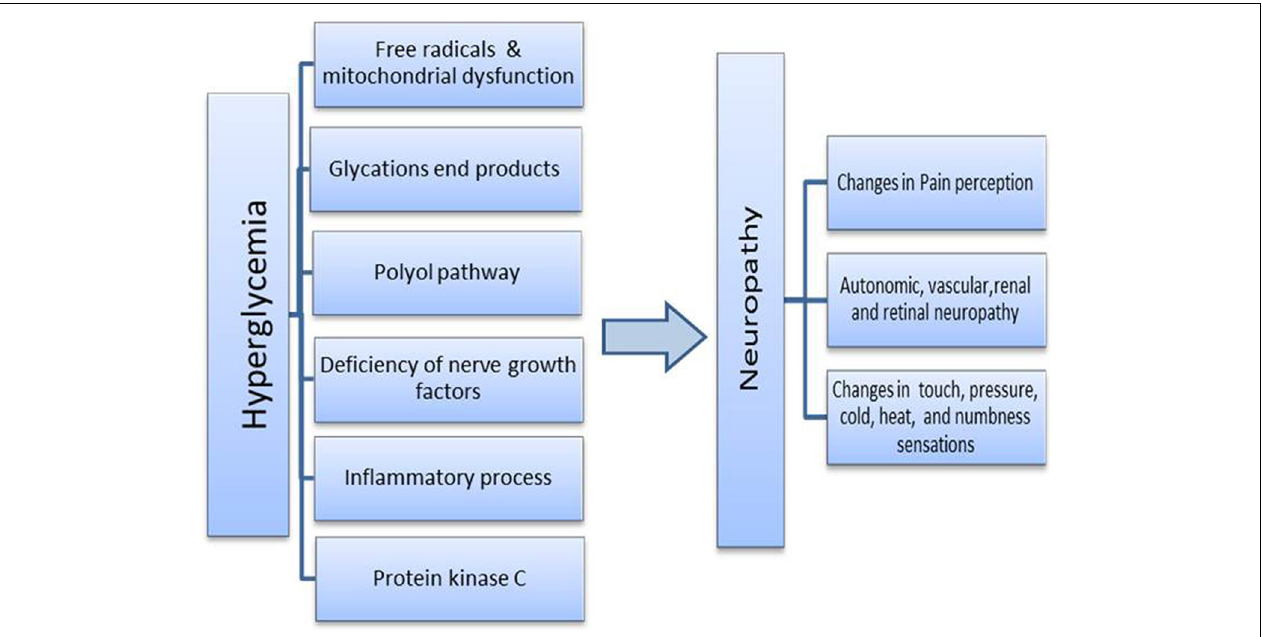
FIGURE 1 | Possible trigger and mechanism involve in development of diabetic